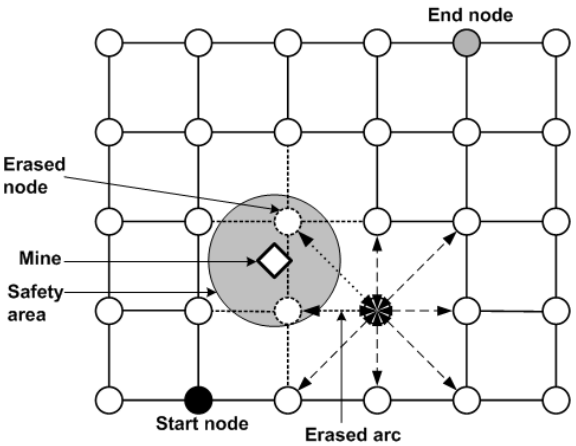
Figure 2: The modified routing structure showing a mine and its safety